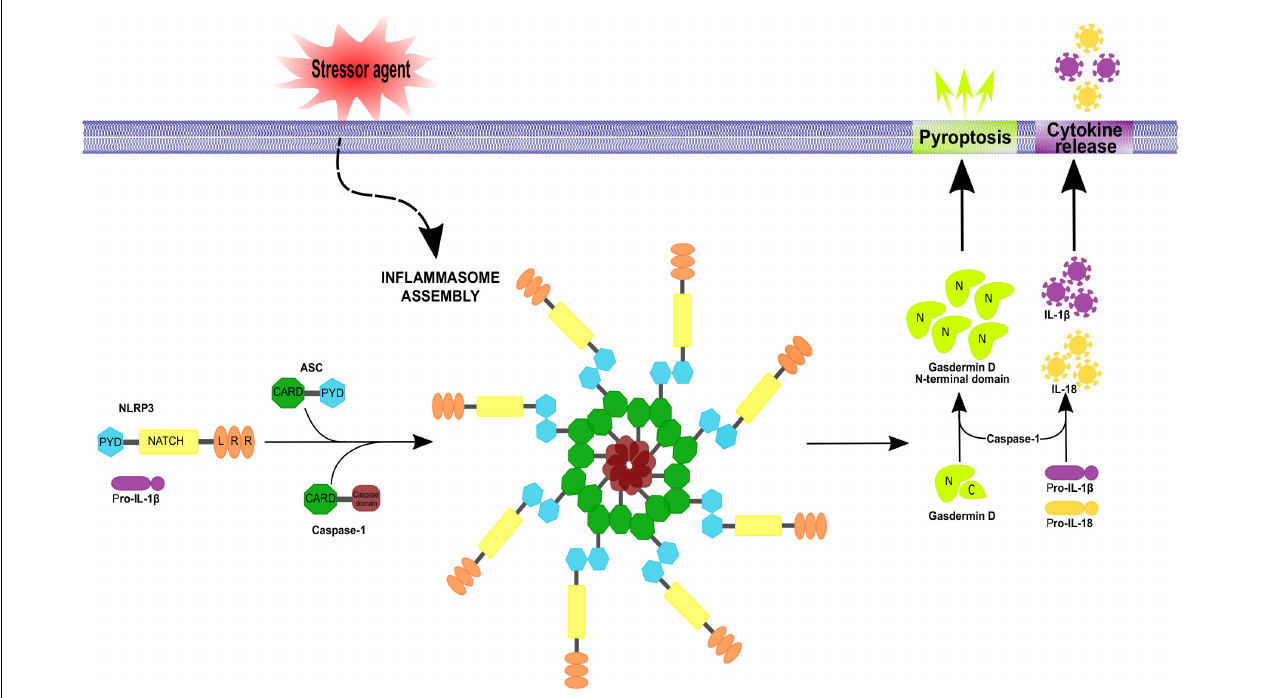
FIGURE 2 | Inflammasome assembly. Inflammasomes assemble in a stimulus-specific manner. Different stressor agents are able to induce inflammasome activation by NLRs or no-NLR inflammasome sensors proteins. Activation of the NLRP3 inflammasome involves ASC and procaspase-1 recruitment, resulting in ASC oligomerization into a macromolecular aggregate and subsequent activation of procaspase-1. Active caspase-1 then cleaves pro-IL-1 β and pro-IL-18 to their mature forms IL-1 β and IL-18 which get secreted. In addition, caspase-1 can cleave gasdermin D, releasing its N-terminal fragment which translocate to the plasma membrane inducing pore formation and pyroptotic cell death. The apoptosis-associated speck-like protein containing a caspase recruitment domain (ASC) is an adaptor protein for many inflammasome complexes and is composed of CARD and PYD domains, the latter being necessary for homotypic interaction with a PYD-containing inflammasome sensor. Procaspase-1 features a CARD domain, in addition to its caspase domain, and homotypic CARD interactions result in direct or indirect ( via ASC) recruitment of procaspase-1 to the inflammasome complex.